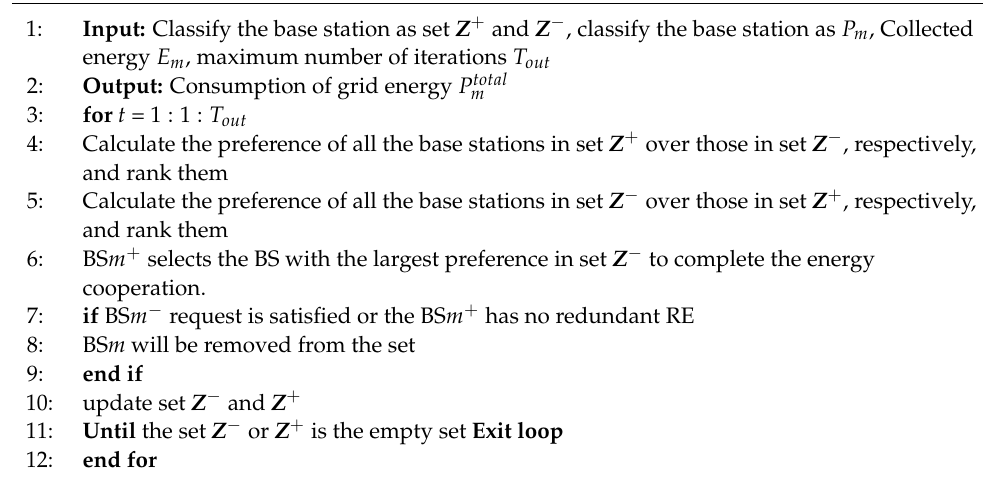
Algorithm 3 Energy Cooperation Algorithm Based on Matching Theory